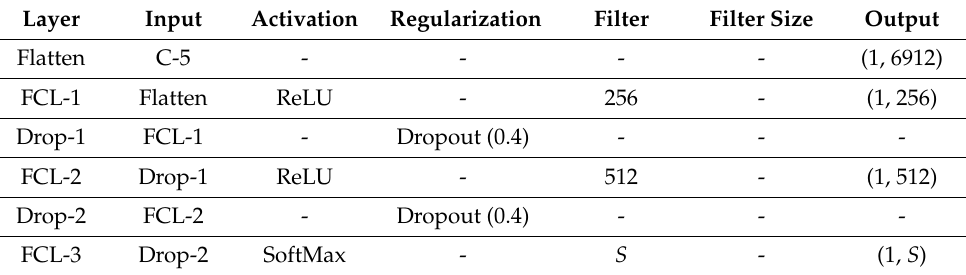
Table 2. Detailed Network Hyperparameters of the Classification Procedure. The abbreviation terminologies in the table are: FCL: Fully connected layers, Drop: Dropout.